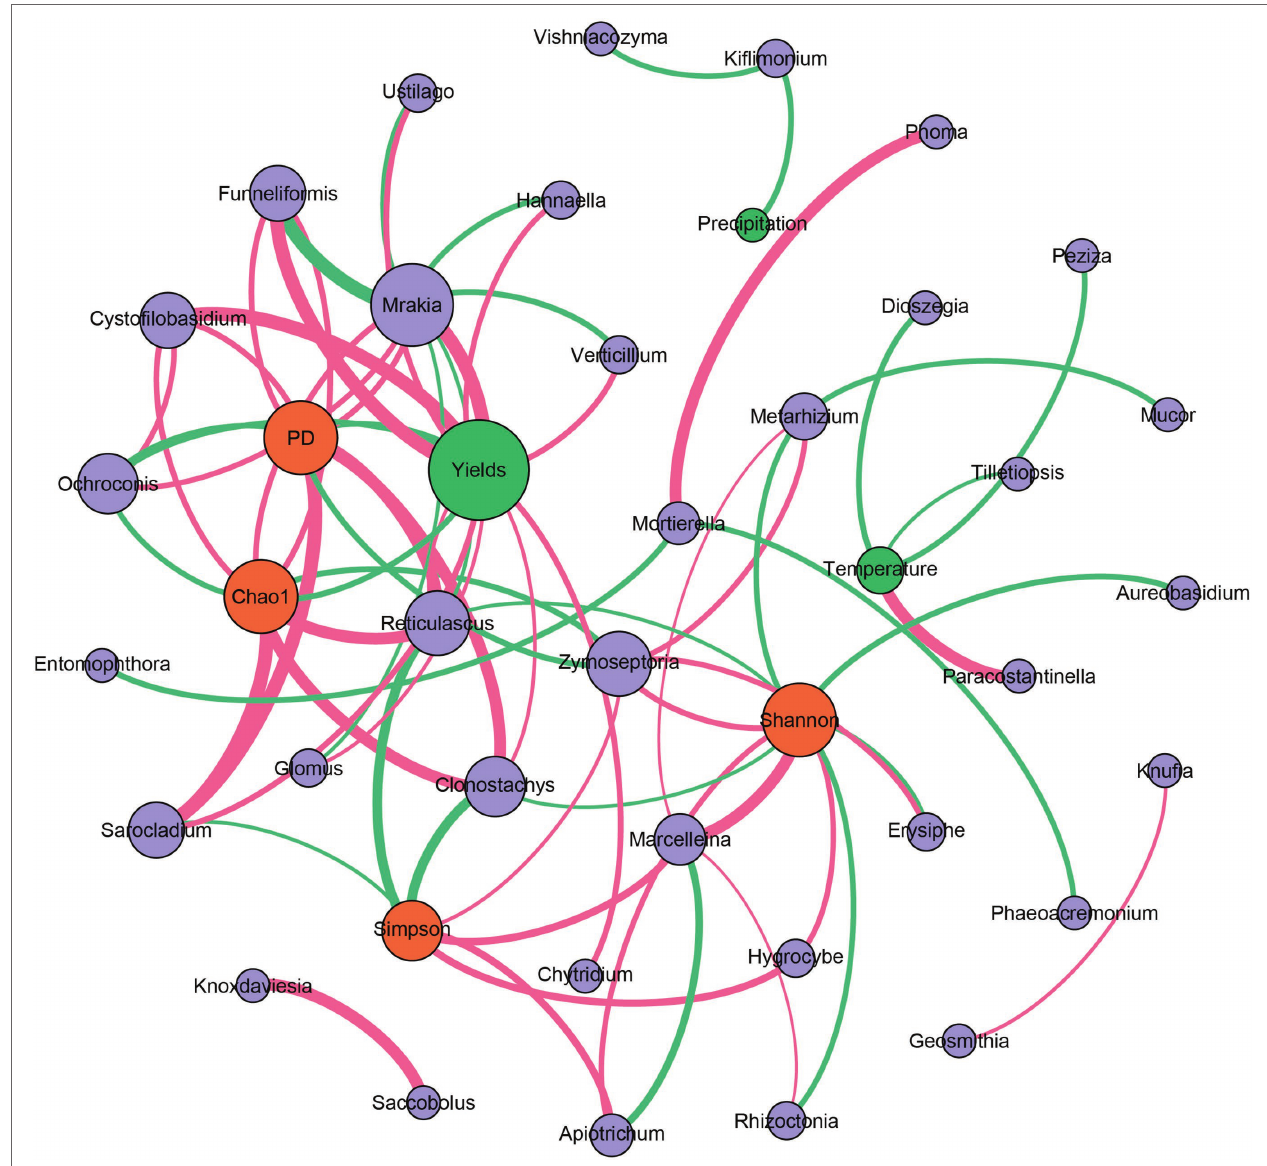
FIGURE 4 | Correlation-based network analysis showing potential interactions between fungal community (purple circle: genera; orange circle: alpha diversity indices) and environmental variables (green circle). A connection indicates a strong (| r | of >0.6) and significant ( p of <0.05) Spearman’s correlation. Red lines indicate negative correlations, while green lines indicate positive correlations. The thickness of each edge is proportional to the value of Spearman’s